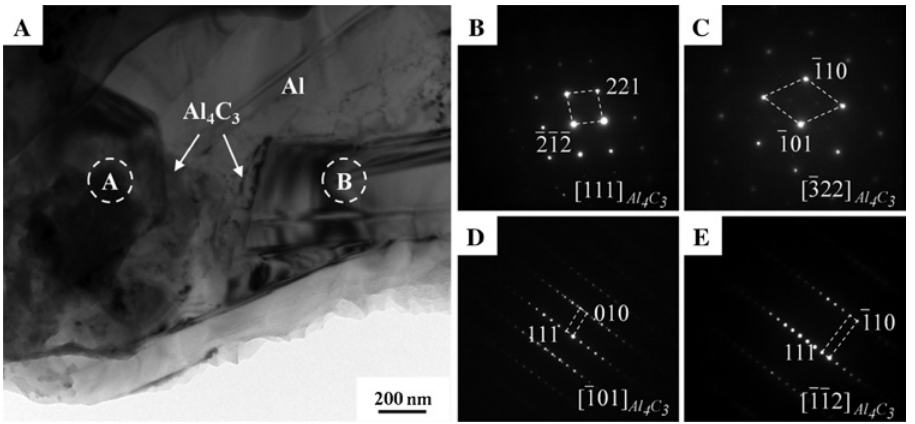
/Al composites after 640 ° C/2 h: (A) morphology, (B, C) series of the rotated diffraction pattern of area Figure 3: Interface production in Gr f A, (D, E) series of the rotated diffraction pattern of area